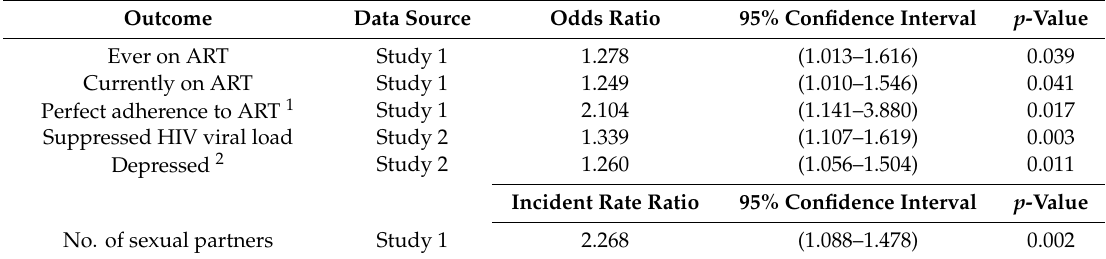
Table 4. Bivariate associations of TW-IP with select